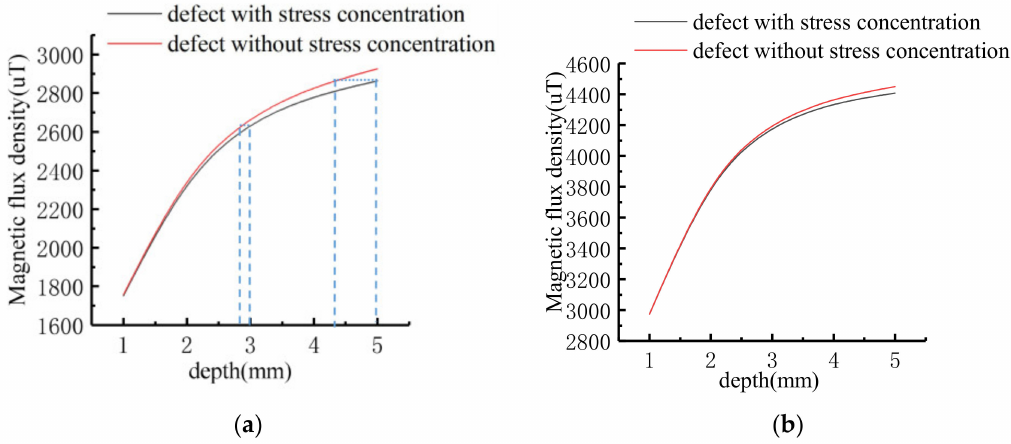
Figure 10. Comparison diagram of signal characters at different depths: ( a ) Tangential amplitude signal; ( b ) Normal peak-to-peak